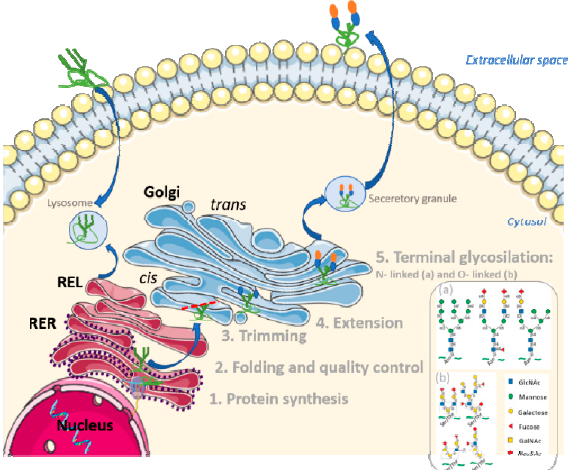
Figure 1. Initiation and maturation of glycoproteins in the ER–Golgi–plasma (Endoplasmic reticulum–Golgi–plasma) membrane pathway. This illustration outlines an overview of the mechanisms for initiation, trimming, and elongation of the glycoprotein in a human cell. Orange and blue spheres represent the addition of glycans chains to proteins (in green) in the Golgi apparatus. Examples of N -glycans structures ( a ) and O -Glycans structures ( b ) are also represented.